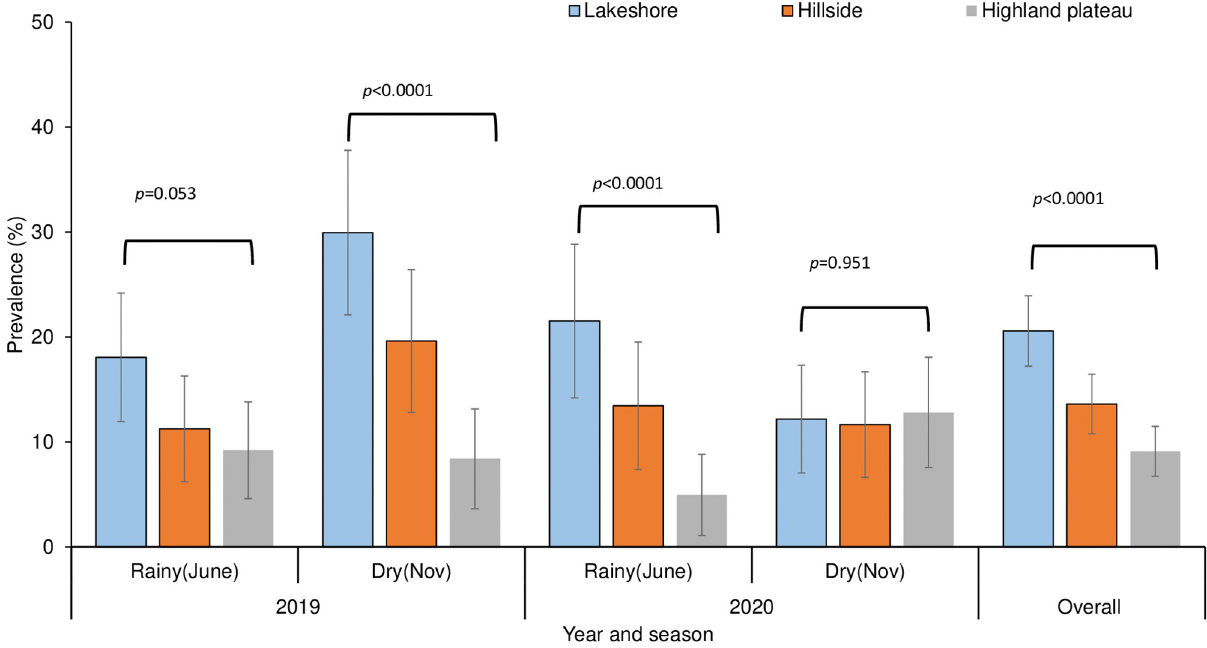
Fig 1. Submicroscopic malaria infection prevalence across topographic zones in rainy and dry